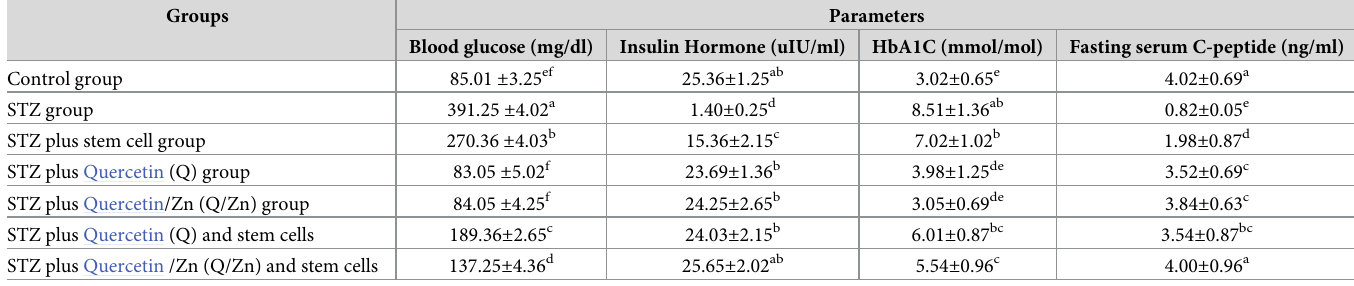
Table 4. Blood glucose level, insulin hormone, HBA1C and fasting serum C-peptide of control and treated male rats with quercetin, quercetin/Zn, or stem cells and their combinations.